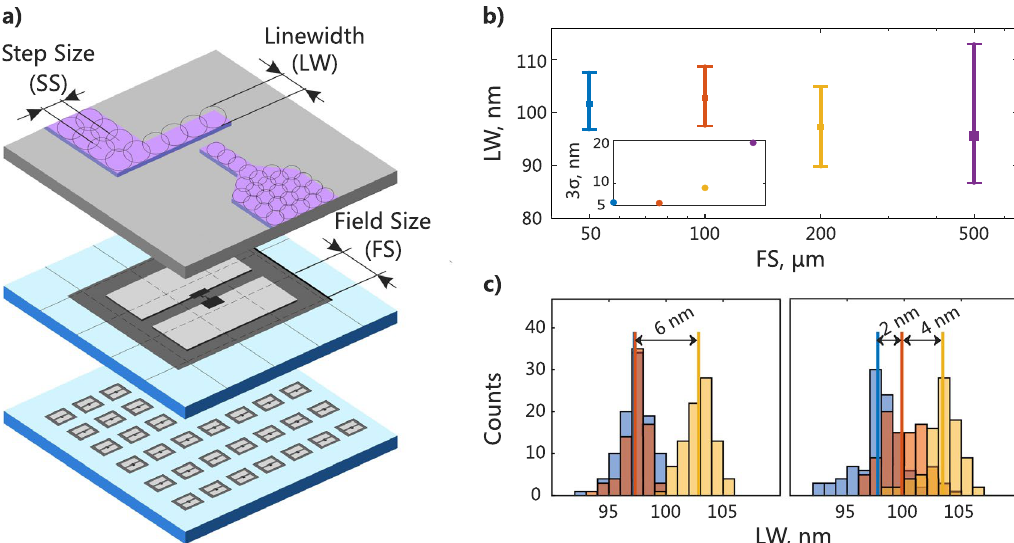
Figure 2. ( a ) Electron beam lithography process. From bottom to top: test chip, enlarged image of a single cell with a junction in the center, hidden image of the Josephson junction in the resist. ( b ) Measured linewidth (LW) variation of the nominal 100 nm feature size grouped by field size. Inlet shows 3σ of linewidth variation. Dot color corresponds to the bars in the main picture. ( c ) Histograms of measured linewidths for 100 nm (blue), 103 nm (red) and 105 nm (yellow) nominal dimensions. When lines are scanned longitudinally (left picture), close nominal linewidth are undistinguishable, since their LW histograms overlap completely and average values are the same. The lines scanned transversely (right) have LW average values difference corresponding to the beam step